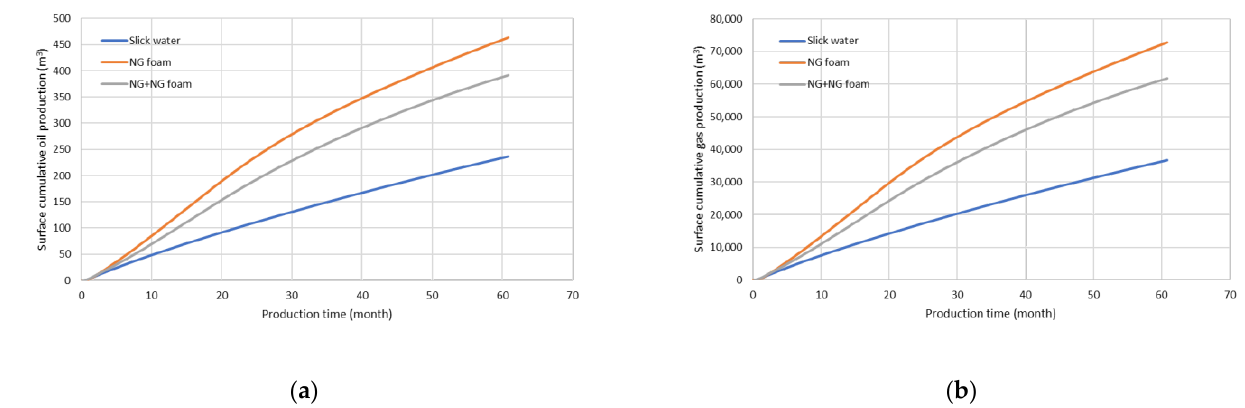
Figure 17. Surface production. ( a ) Cumulative surface oil production, ( b ) Cumulative surface gas production.